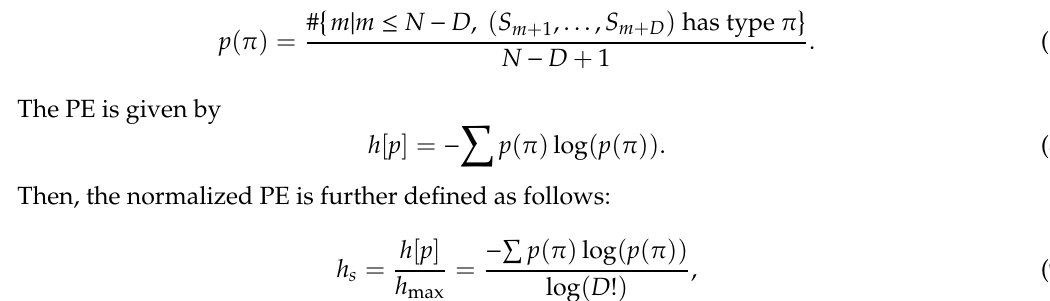
Figure 4. Bifurcation diagrams of the ES-QD laser for ∆ ν = − 14.00 GHz.